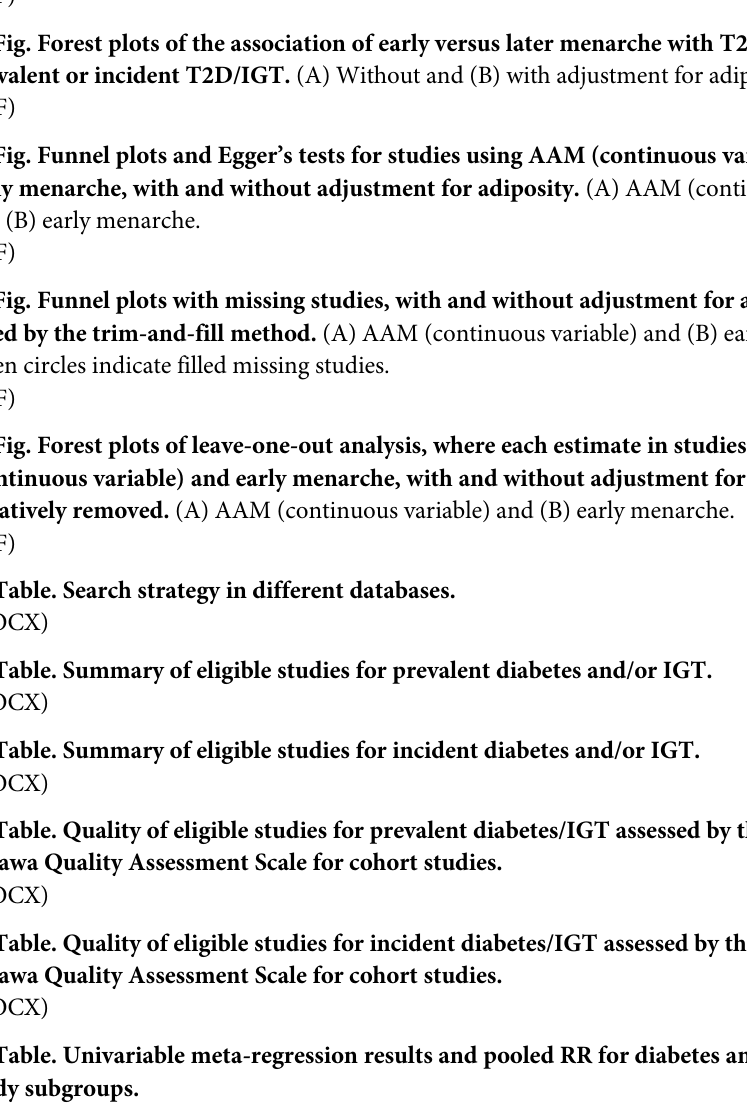
S1 Table. Search strategy in different databases. S2 Table. Summary of eligible studies for prevalent diabetes and/or IGT. S3 Table. Summary of eligible studies for incident diabetes and/or IGT. S4 Table. Quality of eligible studies for prevalent diabetes/IGT assessed by the Newcastle– Ottawa Quality Assessment Scale for cohort studies. S5 Table. Quality of eligible studies for incident diabetes/IGT assessed by the Newcastle– Ottawa Quality Assessment Scale for cohort studies. S6 Table. Univariable meta-regression results and pooled RR for diabetes and IGT in study